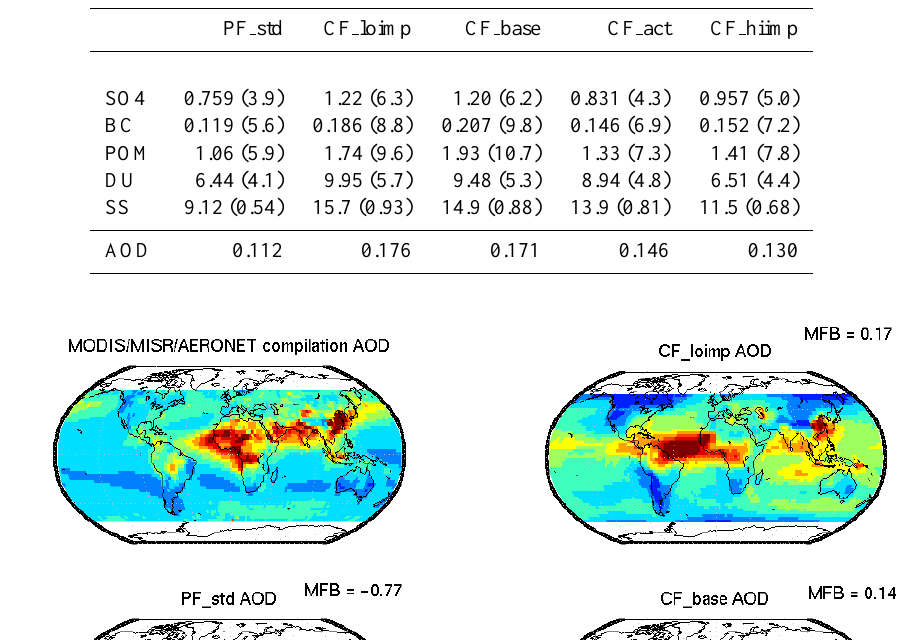
Table 5. Global and annual mean aerosol mass burdens (Tg, except Tg S for sulfate), lifetimes (days) in brackets after the burdens, and aerosol optical depth (AOD) for the five simulations presented in Table 1. The five aerosol species are sulfate (SO4), black carbon (BC), particulate organic matter (POM), dust (DU), and sea salt (SS).